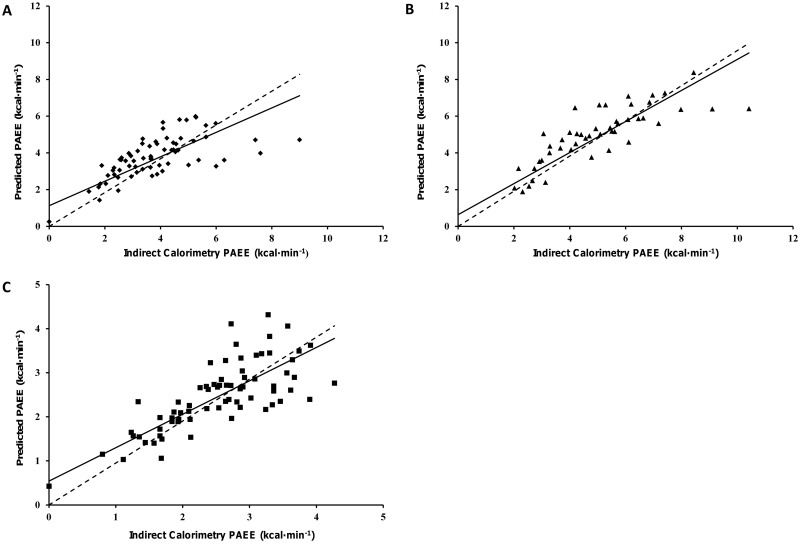
Scatterplots showing the relationship between predicted PAEE for the GT3X+ worn on the hip of the shortest limb and criterion PAEE (Model 1).(A) unilateral amputee group, (B) bilateral amputee group and (C) the left hip of the non-injured control group. The straight line represents the models best fit, and the dotted line indicates the line of identity.